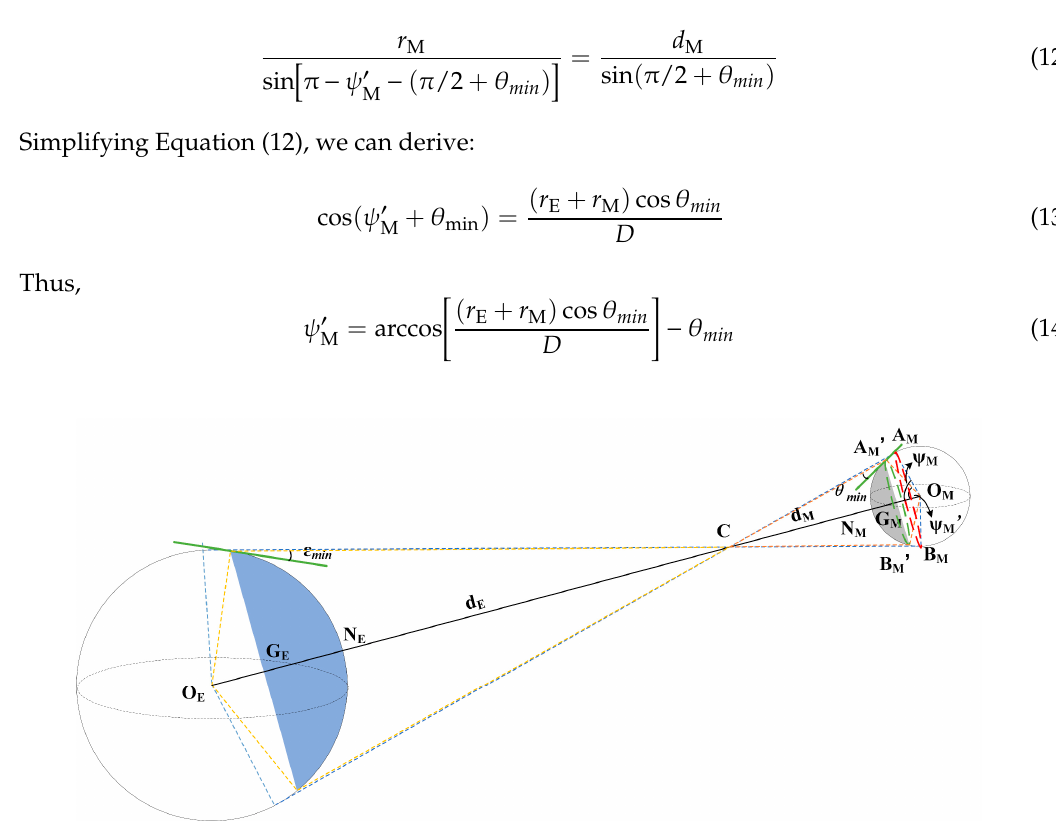
Figure 3. Intervisibility geometry of the Moon and the Earth.